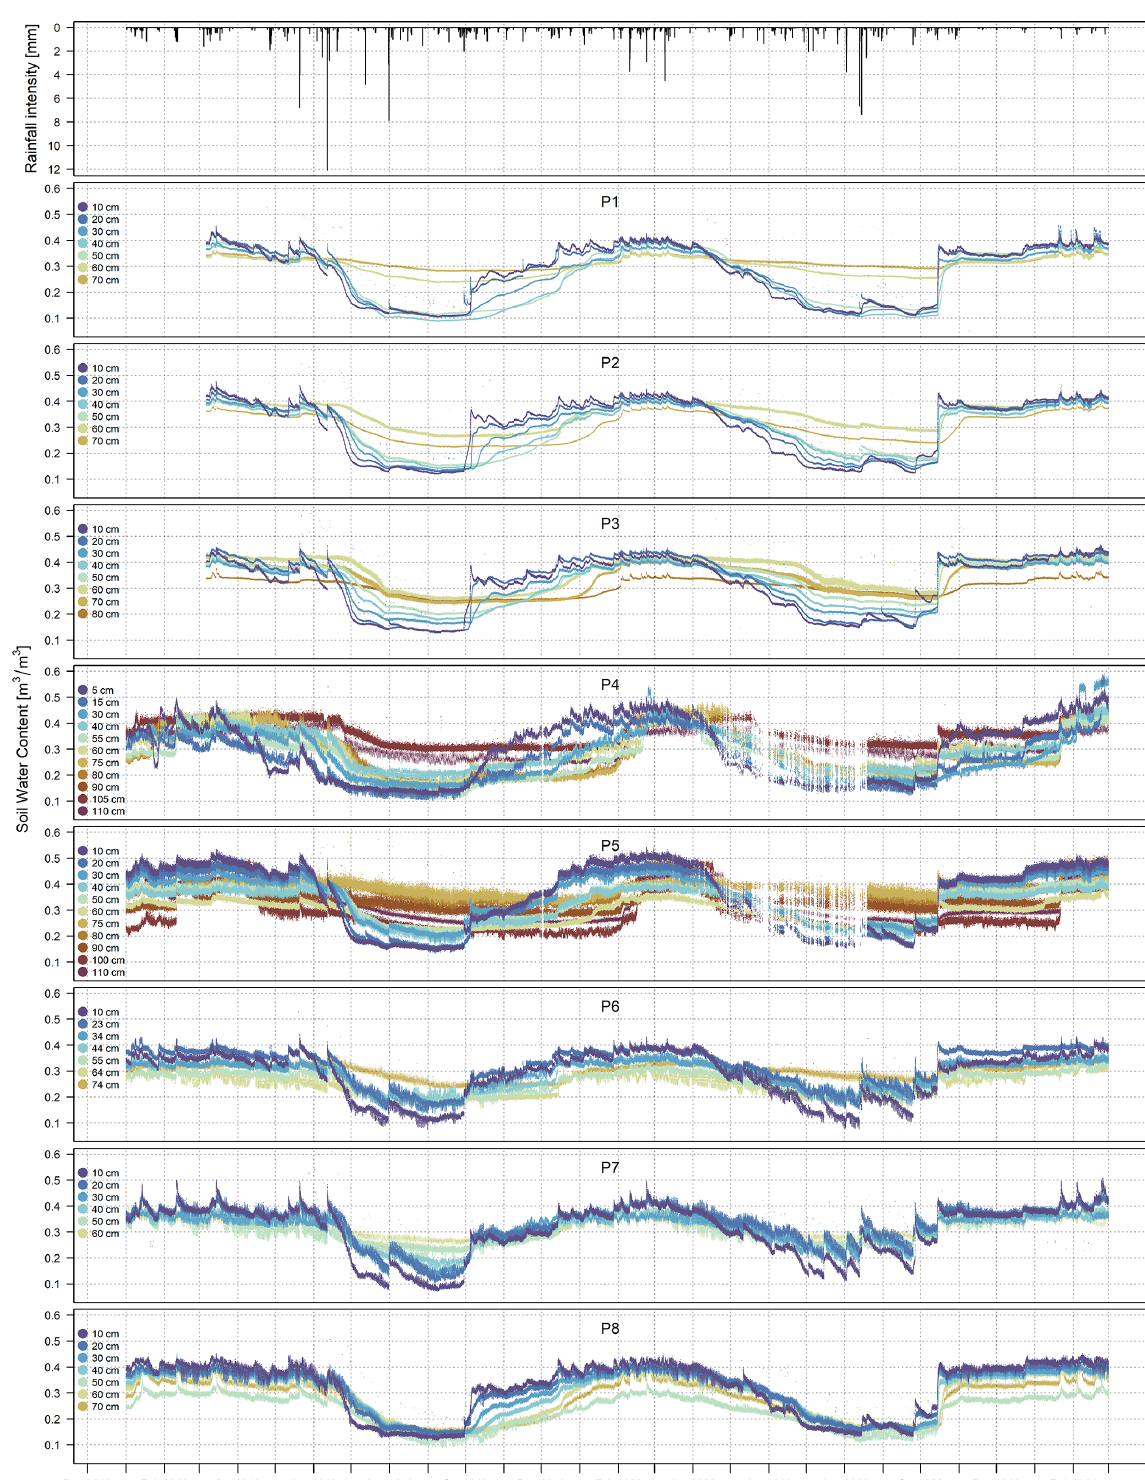
Figure 4. Time series of soil water content data. The plots were made using the data set as it appears in the online archive. The data are plotted using a scientific colour scale from Crameri (2018) chosen according to the principles described in Crameri et al. (2020).